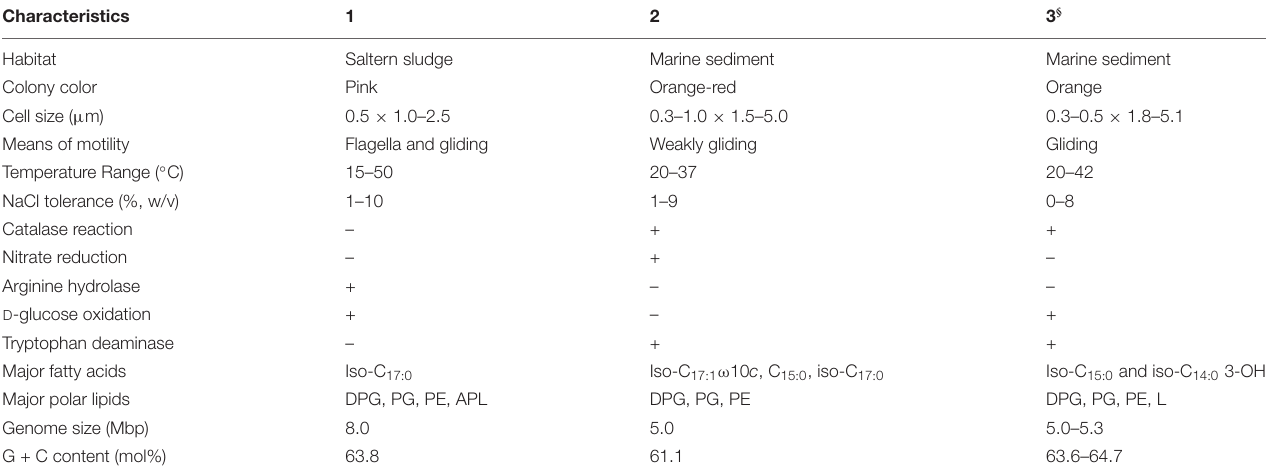
TABLE 1 | Phenotypic characteristics that distinguish Persicimonas from the neighbor genera. Characteristics